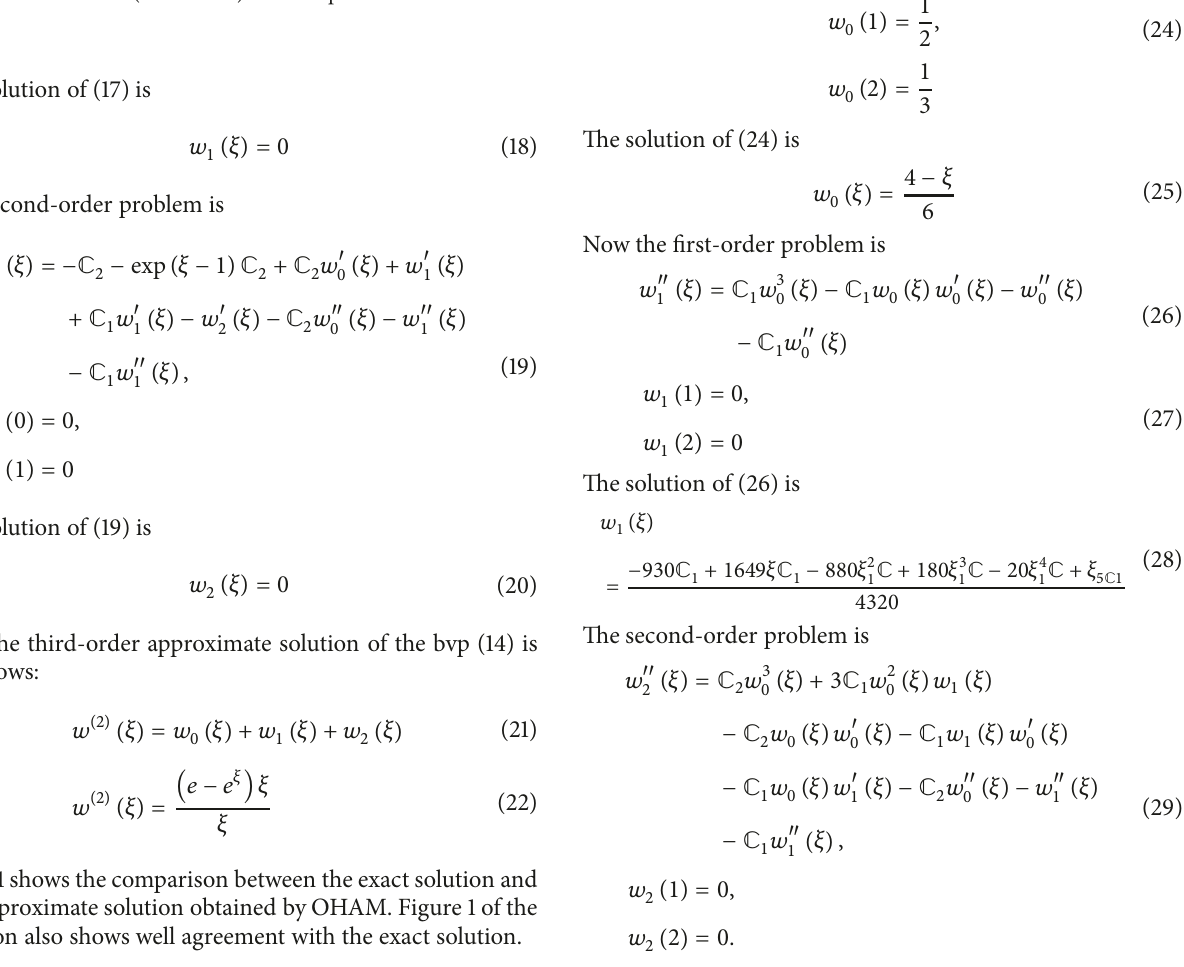
Figure 1: Comparison between exact solution (dashed line) and approximate solution (dotted line) for example